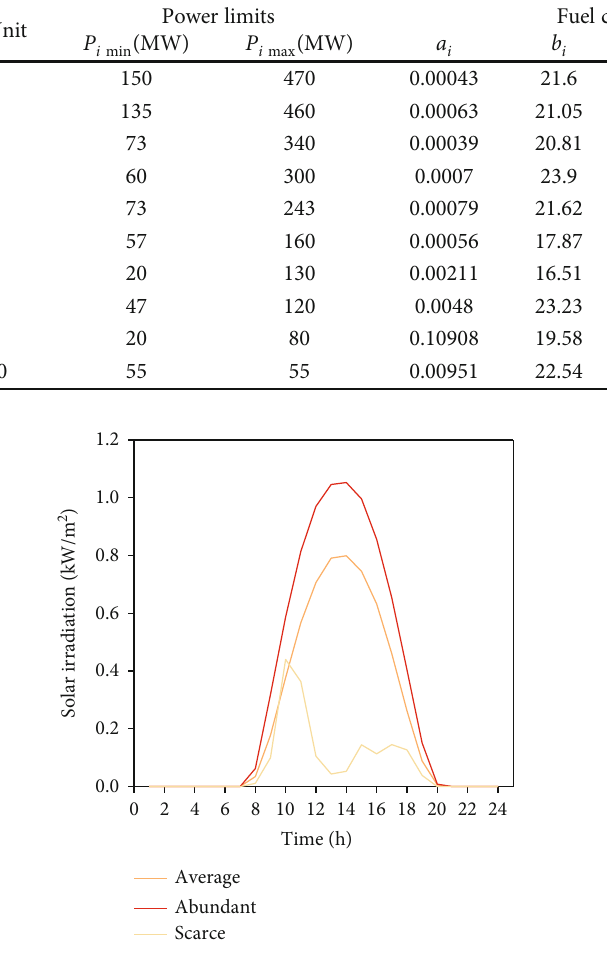
Figure 2: Twenty-four-hour solar irradiation in Wa, Ghana (location: 10 ° 1 ′ N and 2 ° 5 ′ W; source: Wa-Polytechnic weather station, Ghana).